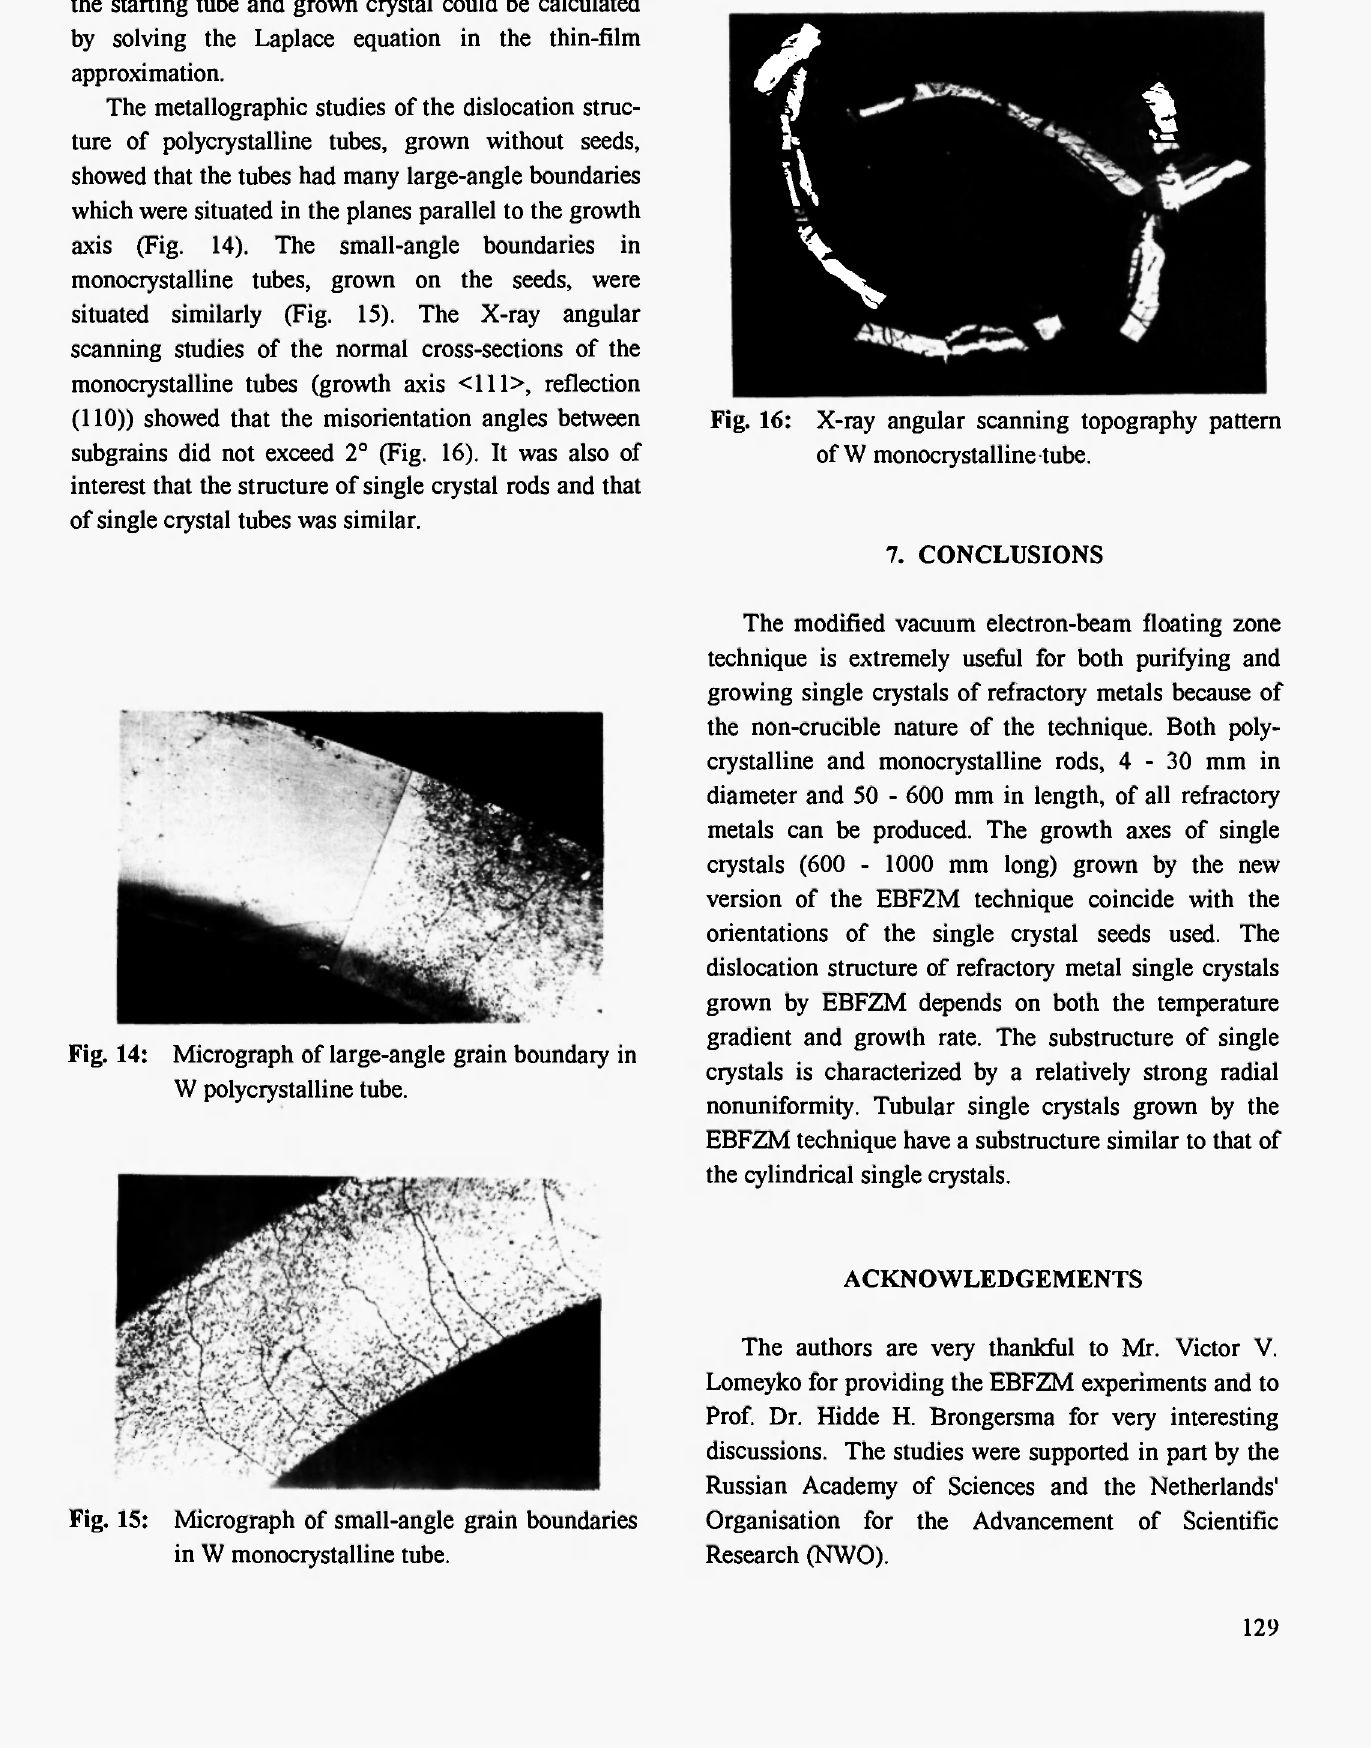
Fig. 15: Micrograph of small-angle grain boundaries in W monocrystalline